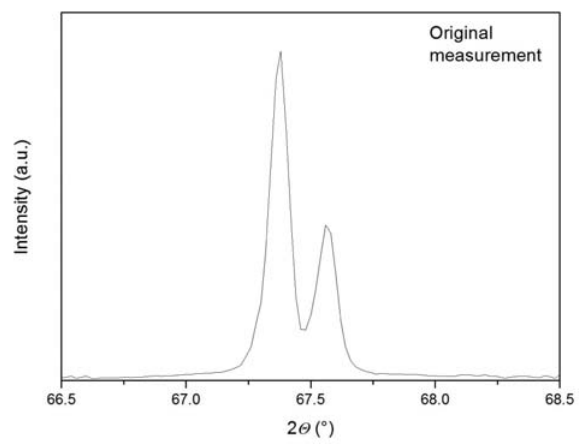
Figure 8. X-ray diffraction of the LaB